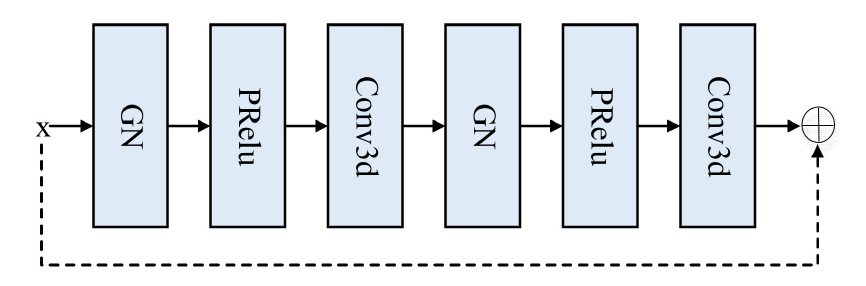
Figure 2. Residual base block